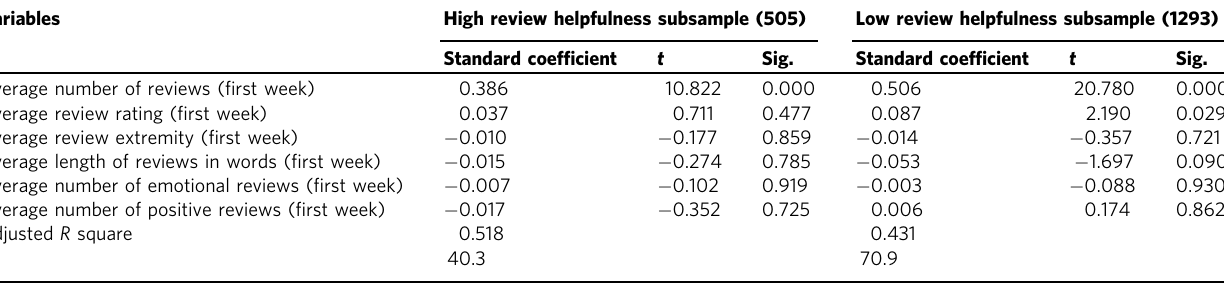
Table 4 Regression analysis for box of fi ce revenue for the second week after release using review helpfulness subsample. Variables